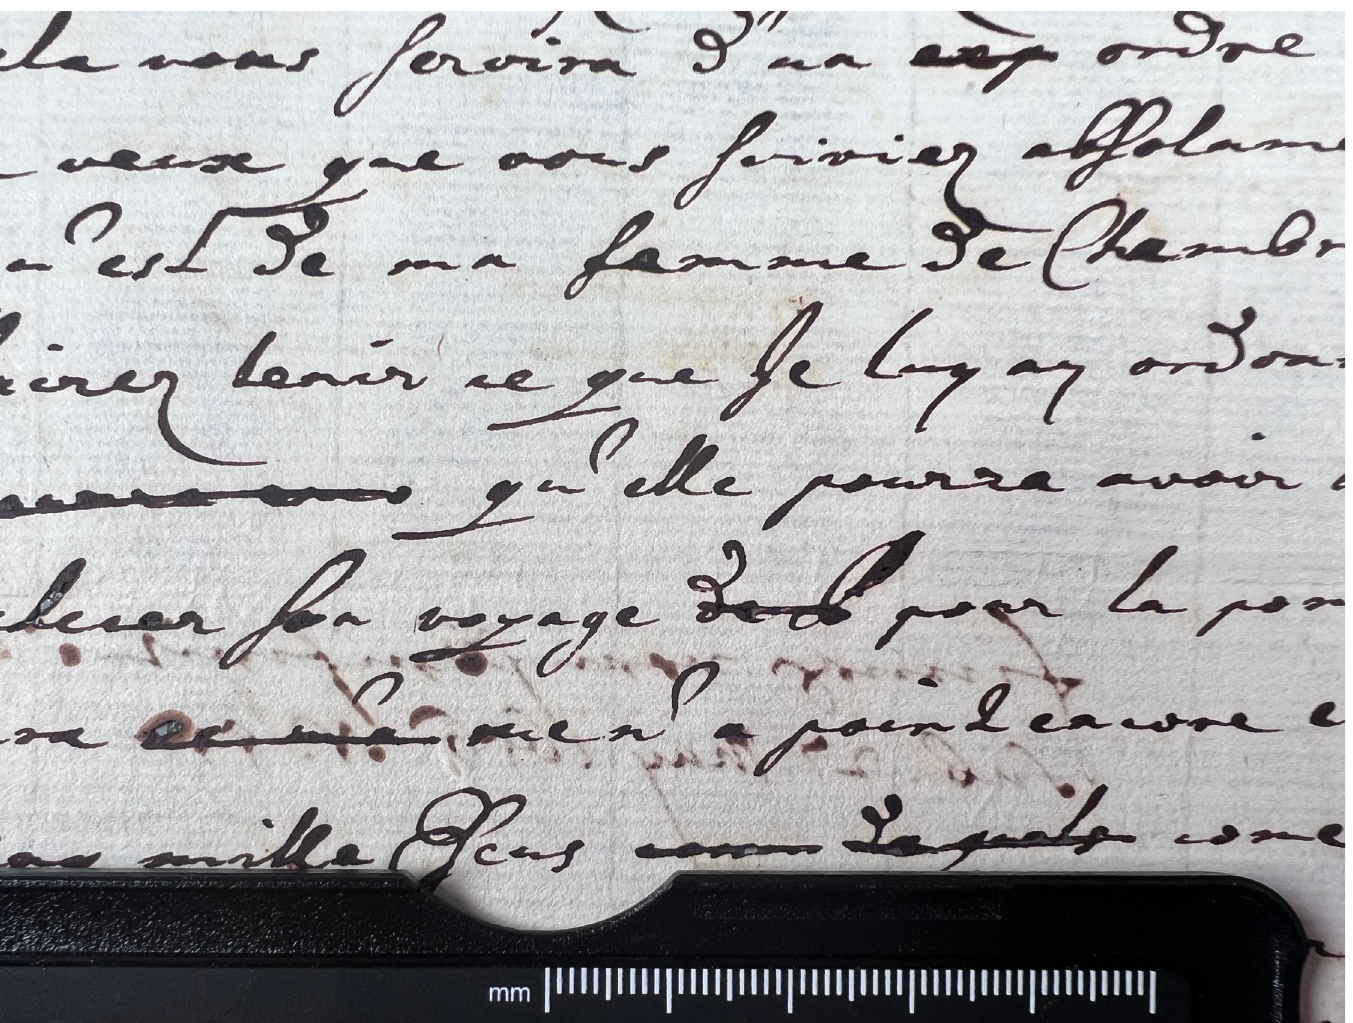
Fig 14. Ink thickness 3. Visual estimation of ink thickness 3, exemplified through a document from volume K 400 of the Azzolino collection.